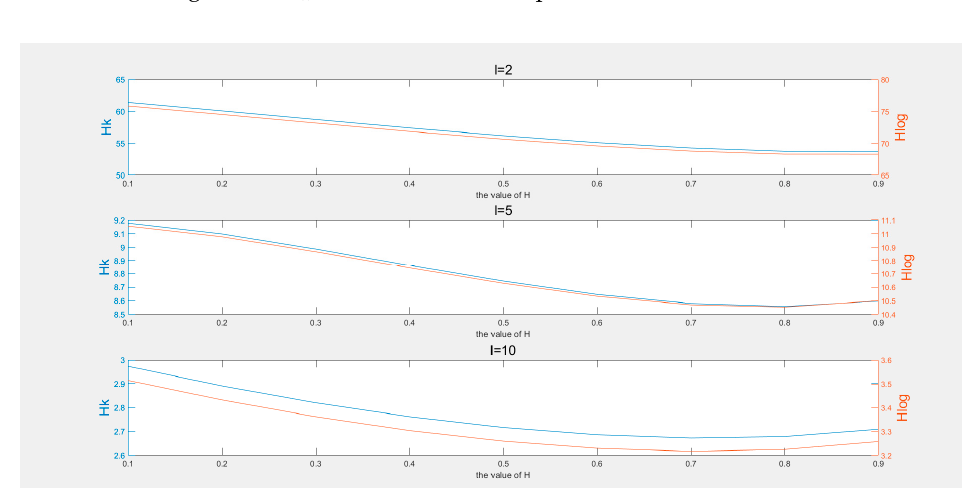
Table 2. Comparison of asymptotic variance of H n with H k and H log 𝓵 = 𝟏𝟎.